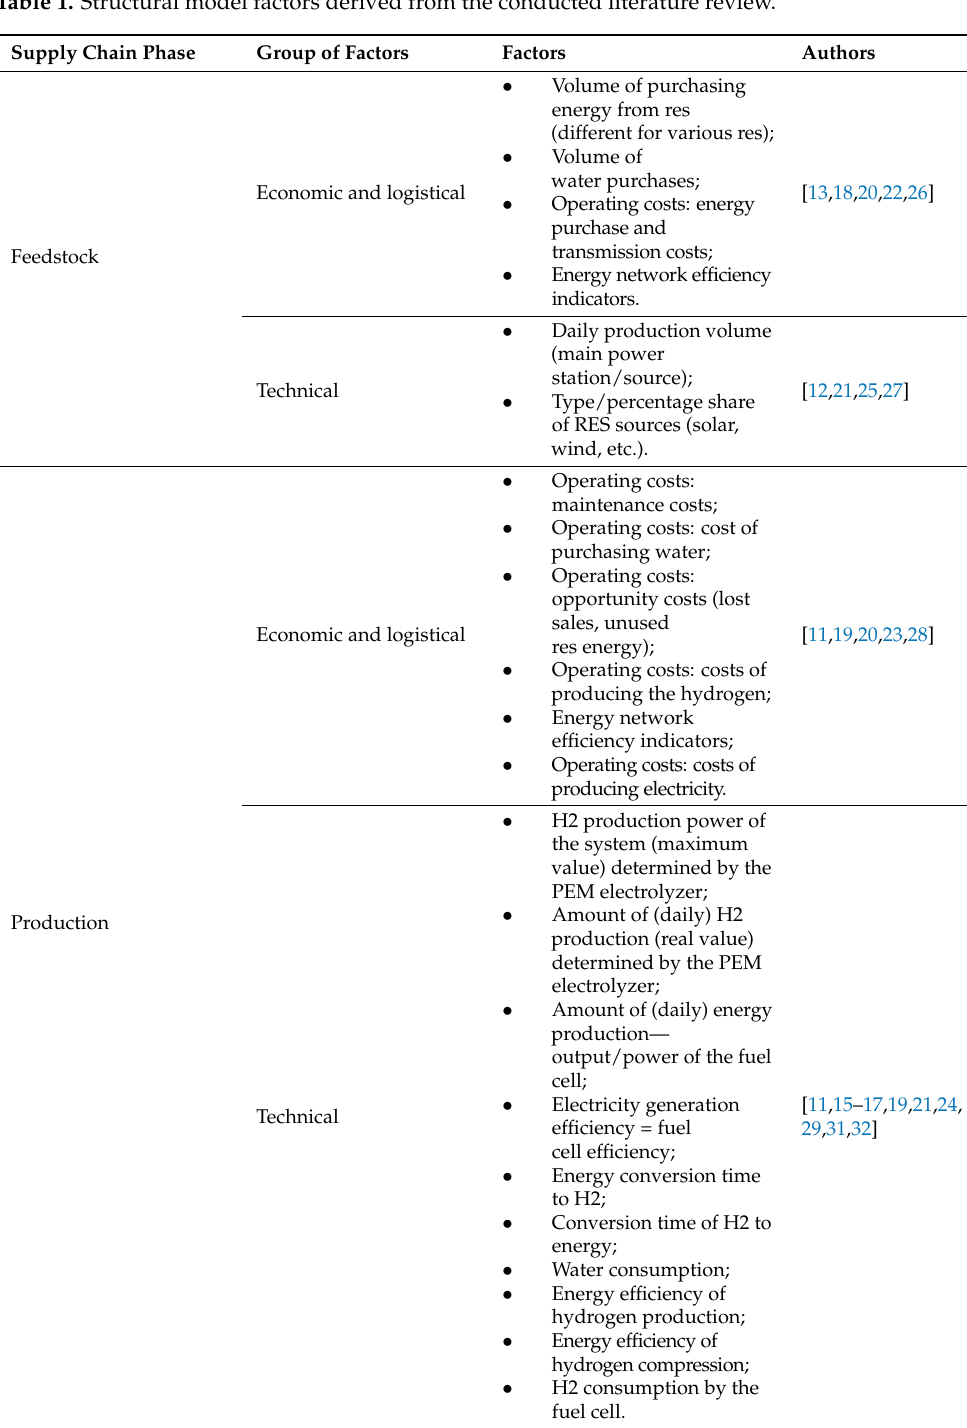
Table 1. Structural model factors derived from the conducted literature